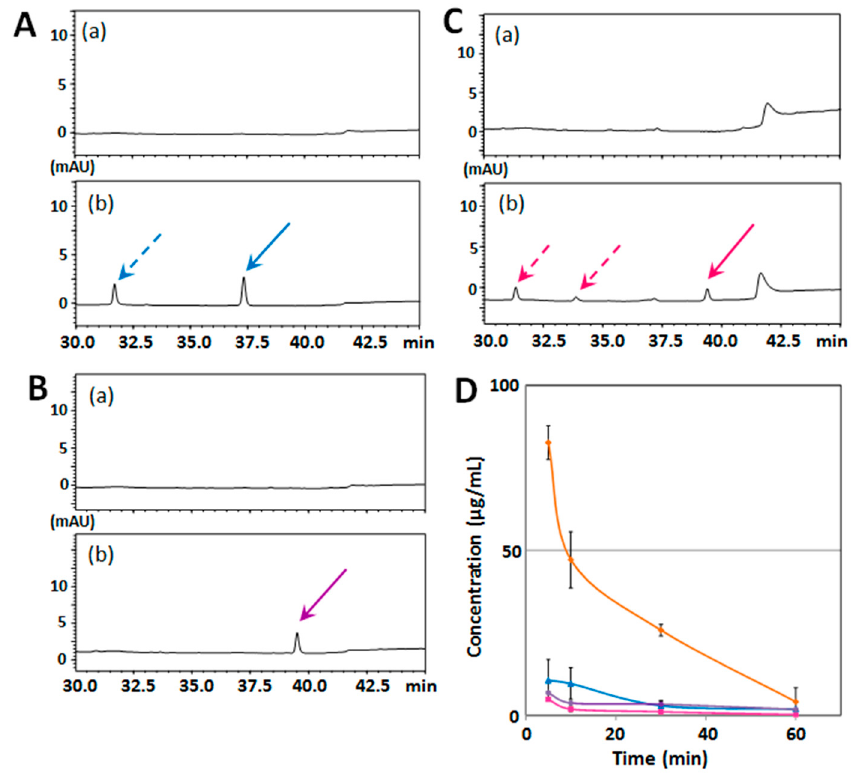
Figure 4. HPLC chromatograms of serum from vehicle-treated mouse ( a ) and after ( b ) i.p. injection with NBT ( A ), TGT ( B ), or NDD ( C ). Solid arrows are each PMFs and dashed arrows are putative metabolites of PMFs. ( D ) Time-course of serum concentration profiles of HMF (orange line), NBT (blue line), TGT (purple line), and NDD (red line) following i.p. administration. Values are the means ± SEM.